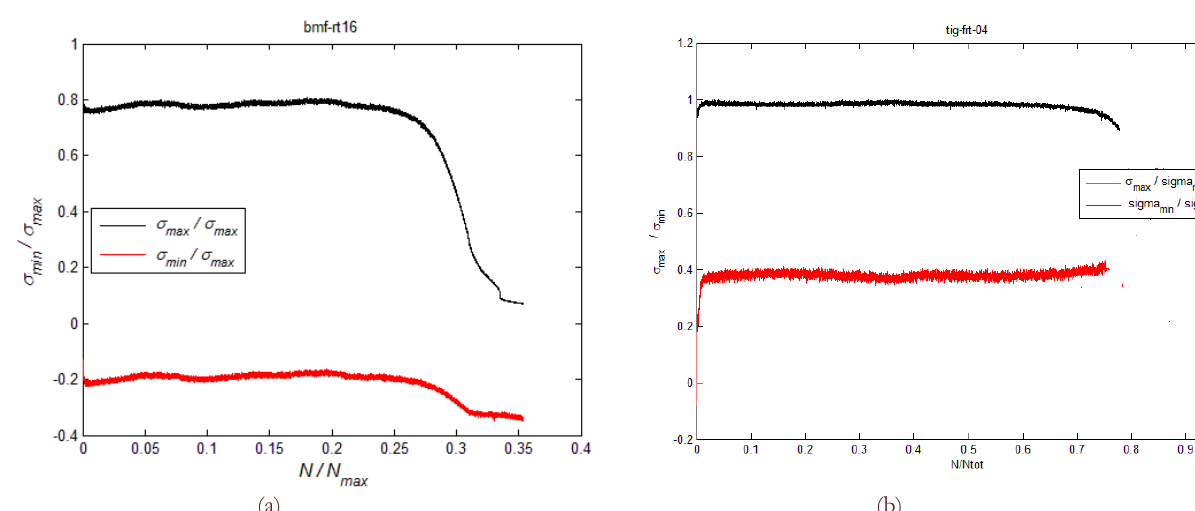
Figure 5: Peak stress trend of a base (a) and TIG welded specimen (b).